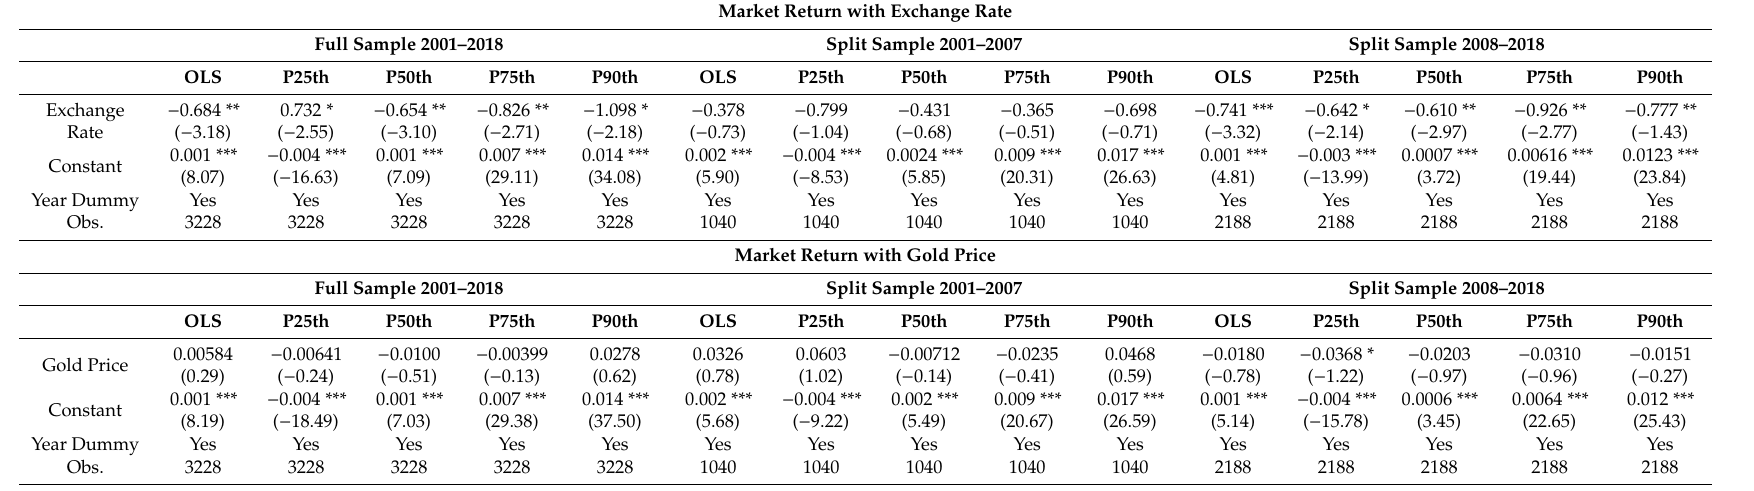
Table 5. Regression results